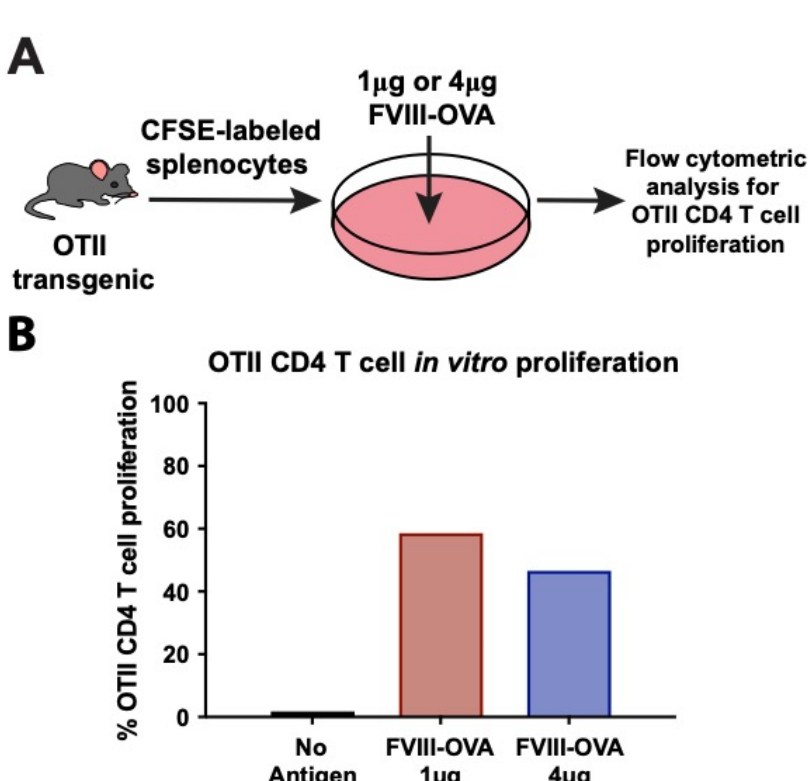
Figure 2. FVIII-OVA CD4 T cell epitope is functional in vitro. ( A ) Splenocytes from OTII transgenic mice were CFSE-labeled, then cultured for 7 days either with no antigen or with 1 or 4 µ g FVIII-OVA in vitro. OTII CD4 T cell proliferation was assessed by flow cytometry. ( B ) Quantification of % OTII CD4 T cell proliferation with no antigen, or 1 µ g or 4 µ g FVIII-OVA. Plotted % is the average of 2–3 individual samples.